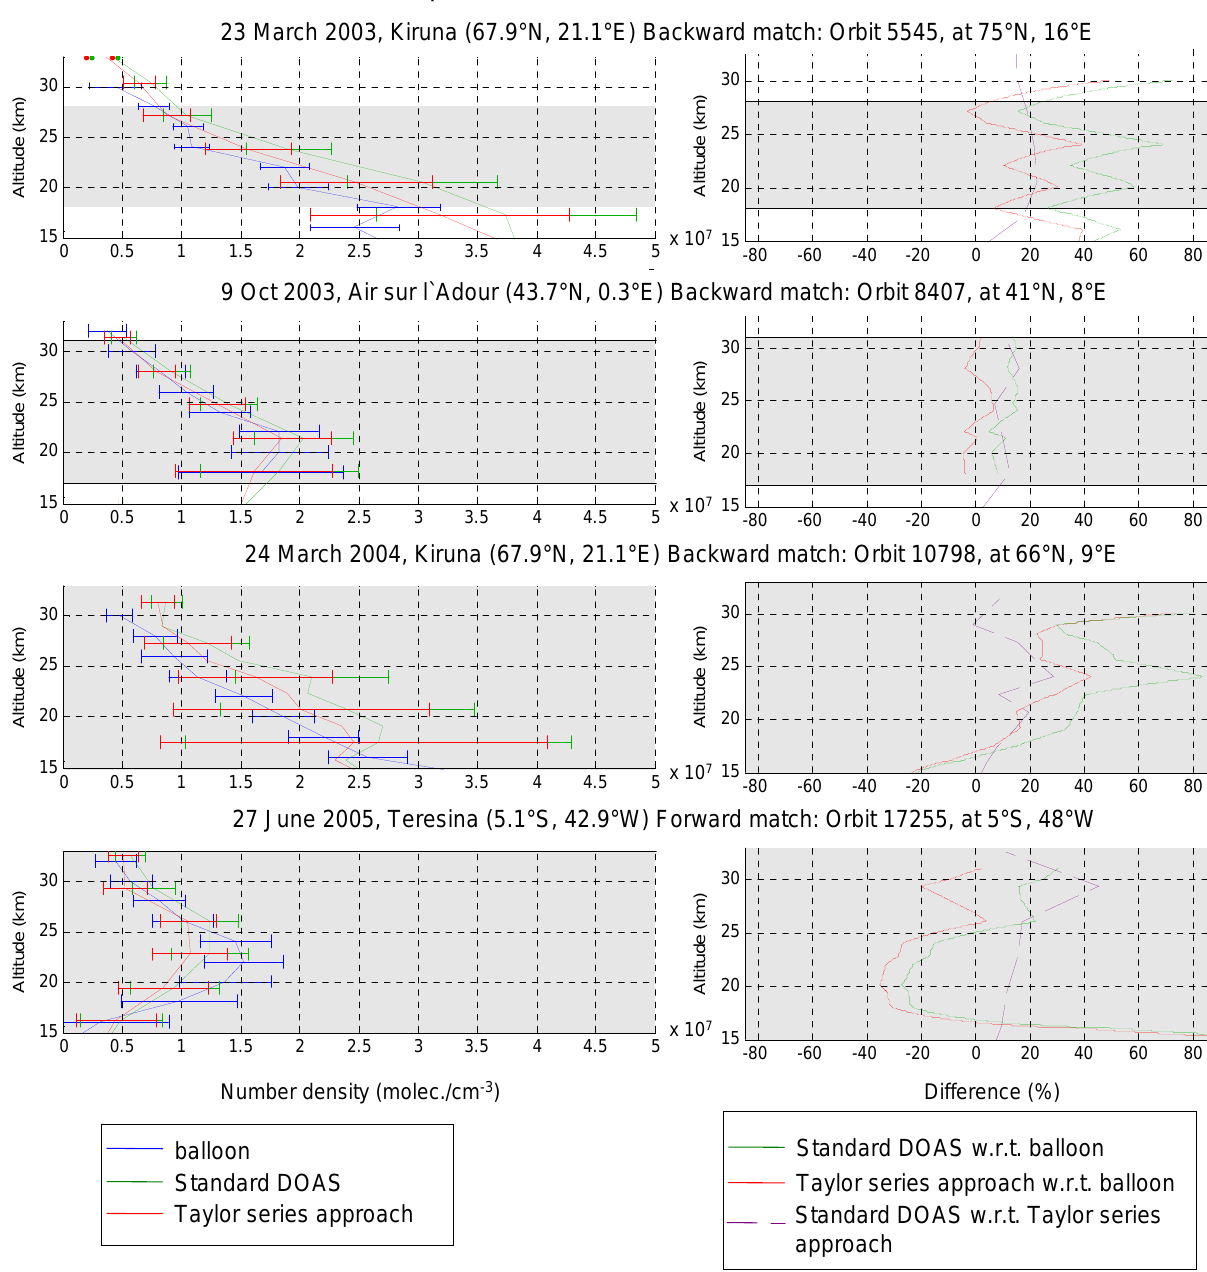
Fig. 9. Comparison of BrO profiles derived from balloon observations (Dorf et al., 2006, 2008) with SCIAMACHY limb retrievals for four different balloon launches as indicated on the titles of the panels. Shown is the comparison either for the backward or the forward match of the trajectory modelling. The match for the largest altitude range with correlated data is chosen. The altitude range where the sounded air masses match is indicated by a gray shading. On the left panel the blue lines represent the balloon profiles photochemically corrected to match the SZA of the SCIAMACHY measurement. The SCIAMACHY measurements are shown as red lines for the Taylor series approach and as green lines for the standard DOAS. On the right panel the relative differences between the SCIAMACHY and balloon profiles (green and red lines) and between the different approaches of SCIAMACHY (violet dashed line) are